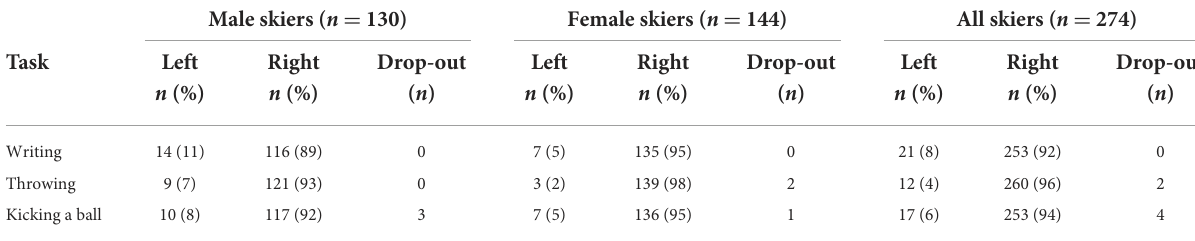
TABLE 3 Distribution of the answers about dominant/non-dominant side for each